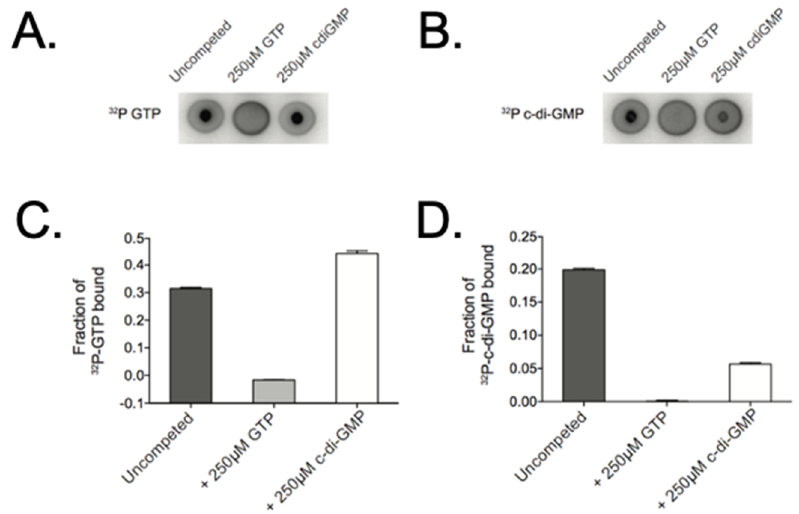
Figure 9. CbrR binds both GTP and c-di-GMP. To ascertain the ability of CbrR to bind nucleotides, purified CbrR was mixed with radio-labeled GTP and c-di-GMP and spotted on a nitrocellulose membrane. Imaging of proteins that bind radio-labeled nucleotide show a dark, intense spot in the middle of the membrane, while nucleotide that does not bind protein diffuses across the membrane to appear as a dark circle around the membrane where the solution was spotted. DRaCALA assays show that CbrR binds GTP ( A ) and c-di-GMP ( B ) in a similar manner. Competition binding shows a slightly higher affinity of CbrR binding GTP over c-di-GMP ( C , D ).